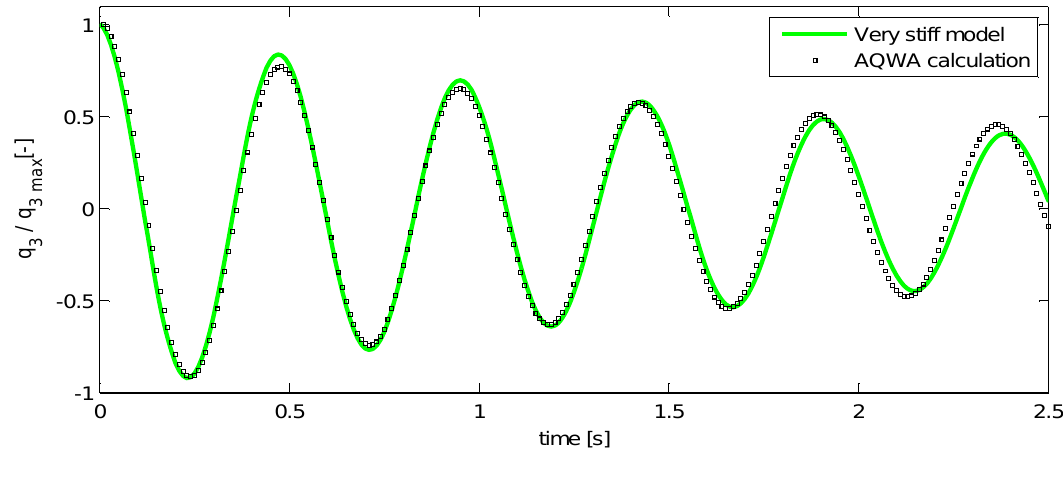
Figure 5. Code-to-code comparison between the hybrid model, including quasi-rigid topside layout pitch response and ANSYS AQWA pitch response in a decay test, normalized by the displacement in pitch at t = 0.